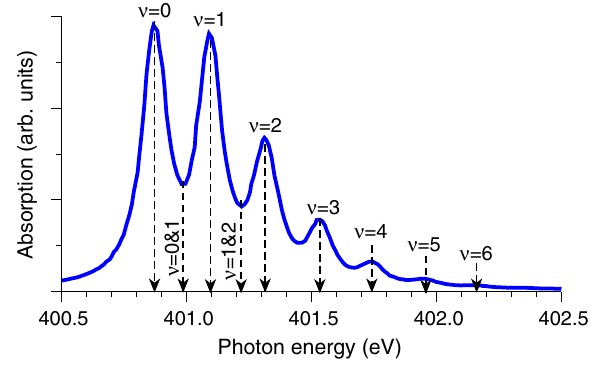
FIG. 1. Experimental x-ray absorption spectrum. The labels show photon energies used for the RPE spectra discussed in this paper: 400.88 eV ( (cid:3) ¼ 0 ), 401.00 eV ( (cid:3) ¼ 0 and 1), 401.11 eV ( (cid:3) ¼ 1 ), 401.24 eV ( (cid:3) ¼ 1 and 2), 401.33 eV ( (cid:3) ¼ 2 ), 401.54 eV ( (cid:3) ¼ 3 ), 401.75 eV ( (cid:3) ¼ 4 ), 401.96 eV ( (cid:3) ¼ 5 ), and 402.15 eV ( (cid:3) ¼ 6